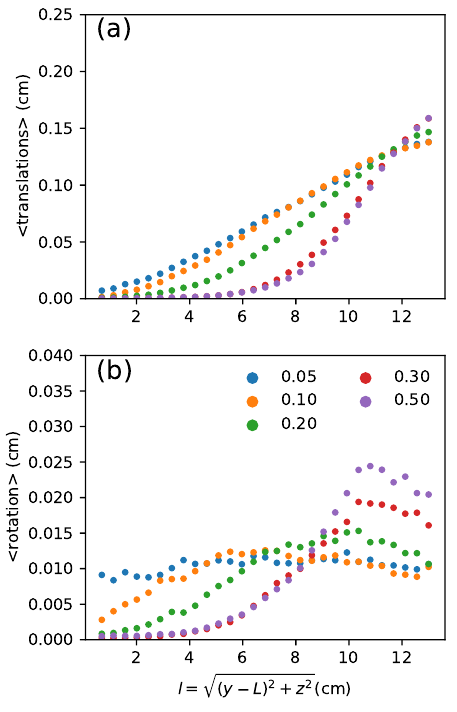
Figure 3. Top, the average translational displacement in the binned zones for di ff erent values of friction. Bottom, the same for rotations. The binning is performed along an axis parallel to the shear bands. The legend corresponds to the value of friction, µ S .